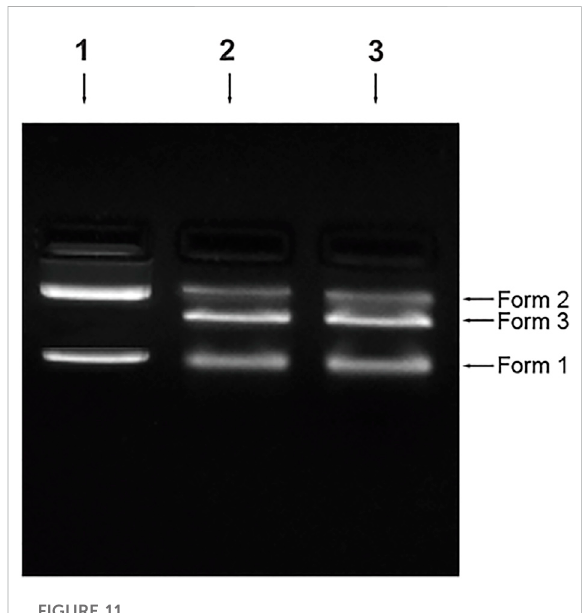
FIGURE 11 Plasmid nicking assay Control (Lane 1), 4-Cl-OPD modi fi ed HSA (Lane 2), positive control-MMS (Lane 3).